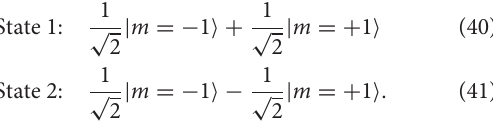
FIGURE 4 | Frequency shifts for different flow degrees s and the corresponding azimuthal orders t for a dipole multiplet at ν component. (Bottom) shifts of the m